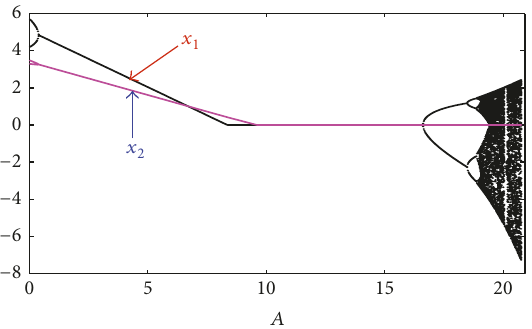
Figure 12: Bifurcation diagram for 𝐴 ∈ (0,0, 20.9184] and (𝛼 1 = 0.42, 𝛼 2 = 0.36) .